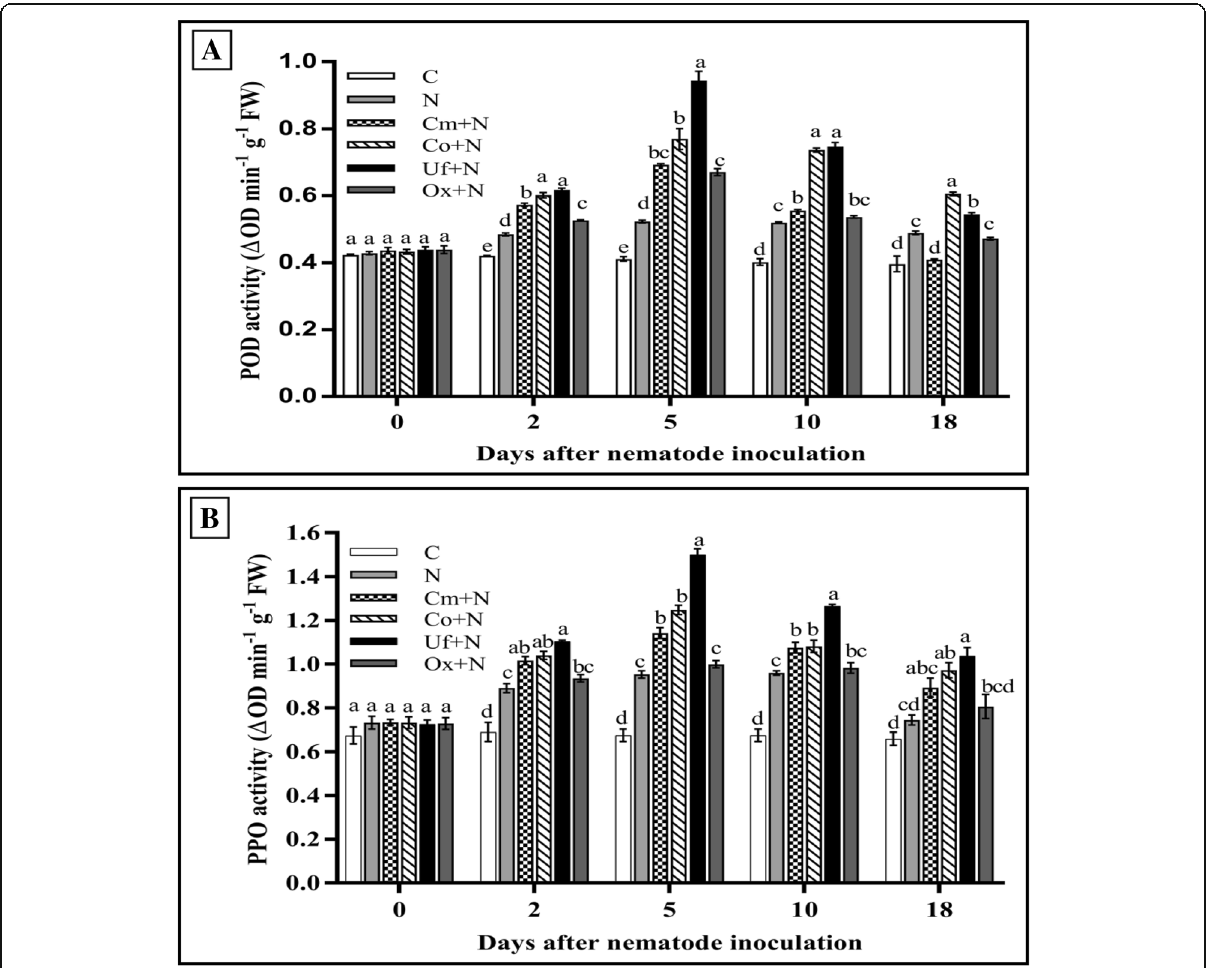
Fig. 2 Activities of POD (peroxidase) ( a ) and PPO (polyphenol oxidase) ( b ) enzymes in the roots of tomato plants inoculated with M . incognita (N) and treated with C . mediterranea (Cm + N), C . officinalis (Co + N), U . fasciata (Uf + N) extracts and the nematicide, oxamyl (Ox + N). Untreated un- inoculated plants served as control (C). Values are the mean of three replicates ± SE. Means followed by different letters within the same time considered different at P ≤ 0.05 according to Tukey ’ s HSD